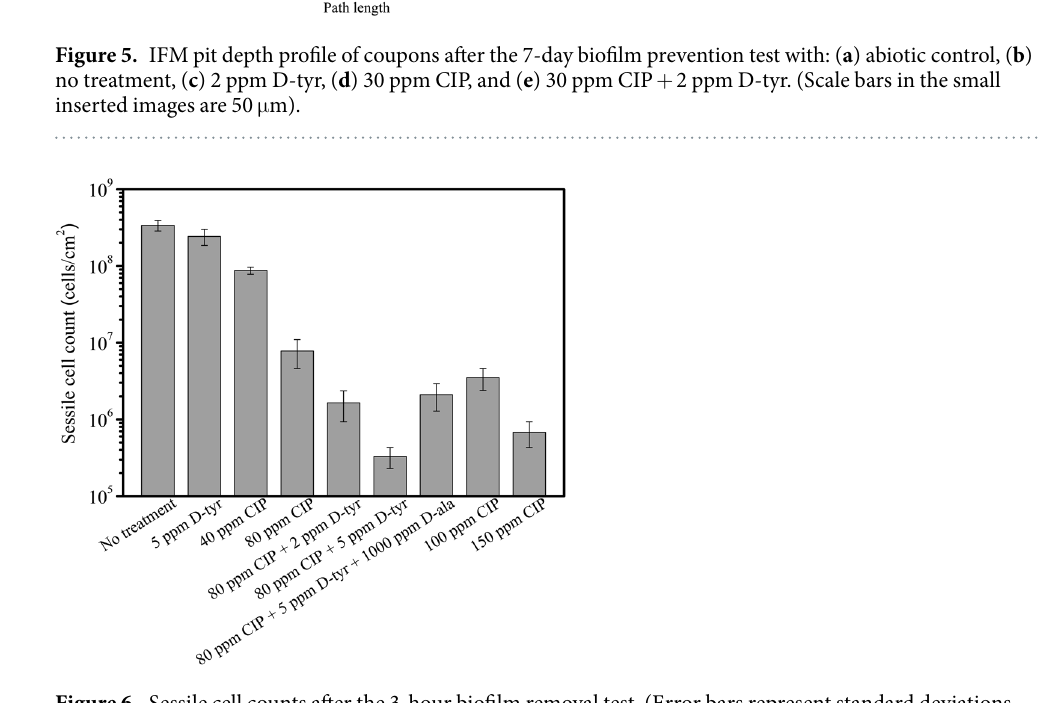
Figure 6. Sessile cell counts after the 3-hour biofilm removal test. (Error bars represent standard deviations, statistical reference point n =